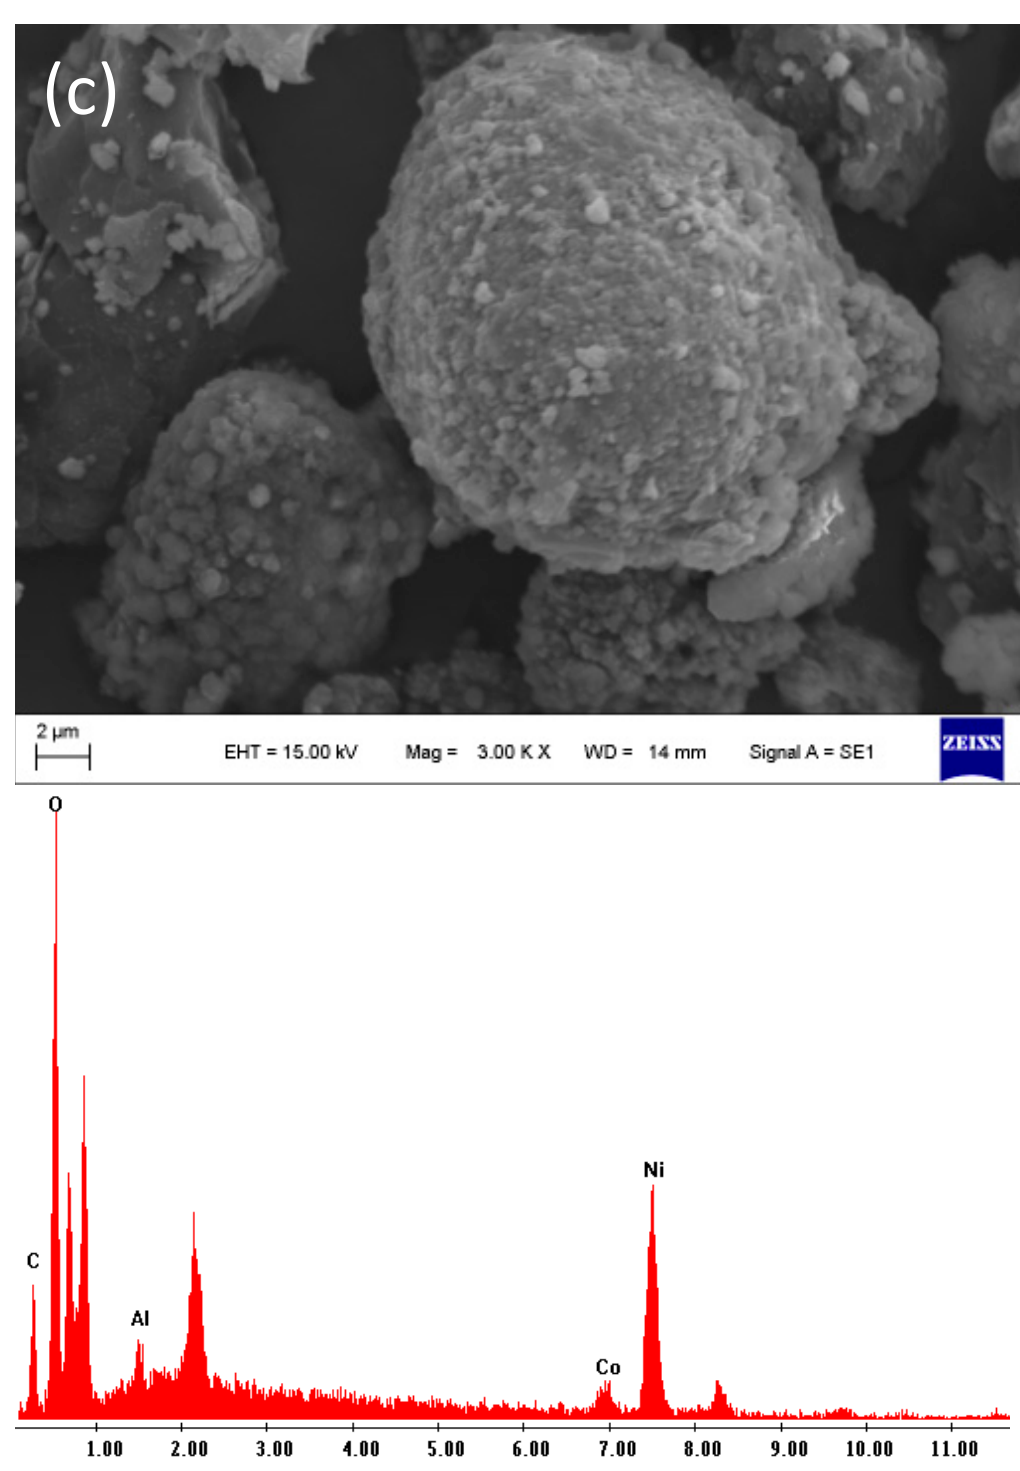
Figure 2. SEM micrographs and EDS spectra from particles of each black mass sample, ( a ) SBM, ( b ) VBM-1, and ( c ) VBM-2.